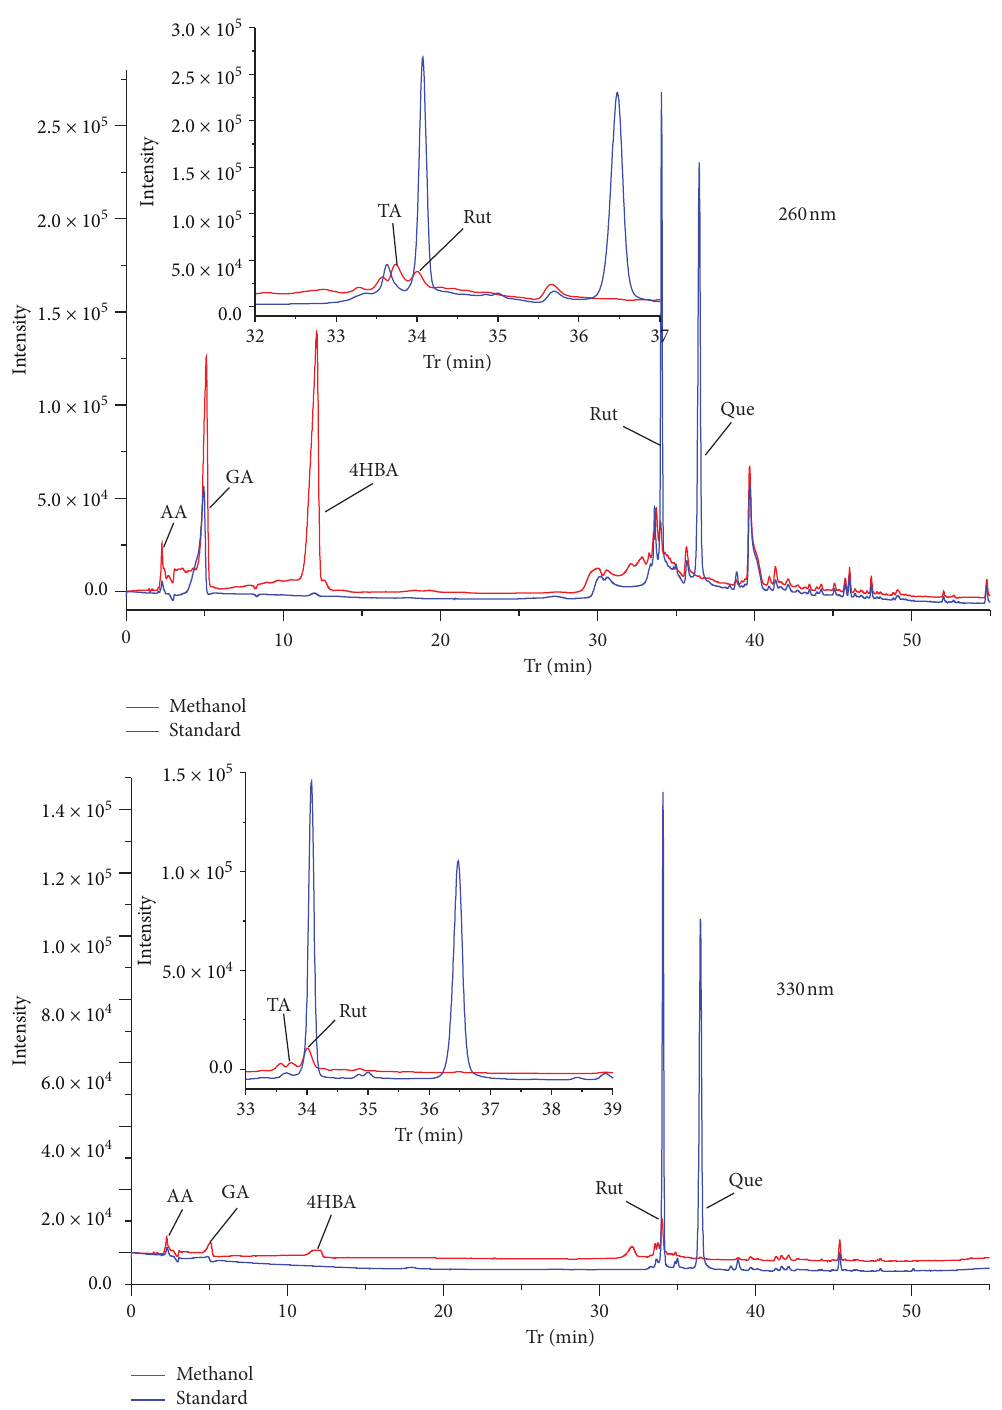
Figure 2: HPLC chromatograms of hydromethanolic extract Salvia officinalis and standards (GA: gallic acid; AA: ascorbic acid; 4-HBA: 4- hydroxybenzoic acid; Rut: rutin; TA: tannic acid; Quer: quercetin) at wavelengths 260 and 330